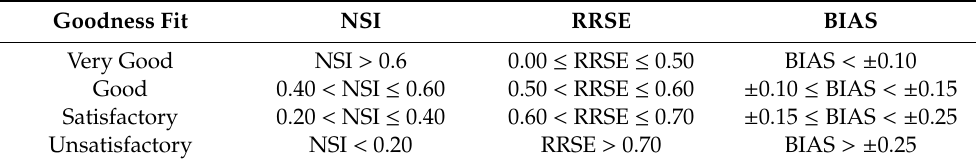
Table 1. Classification of best fit, according to